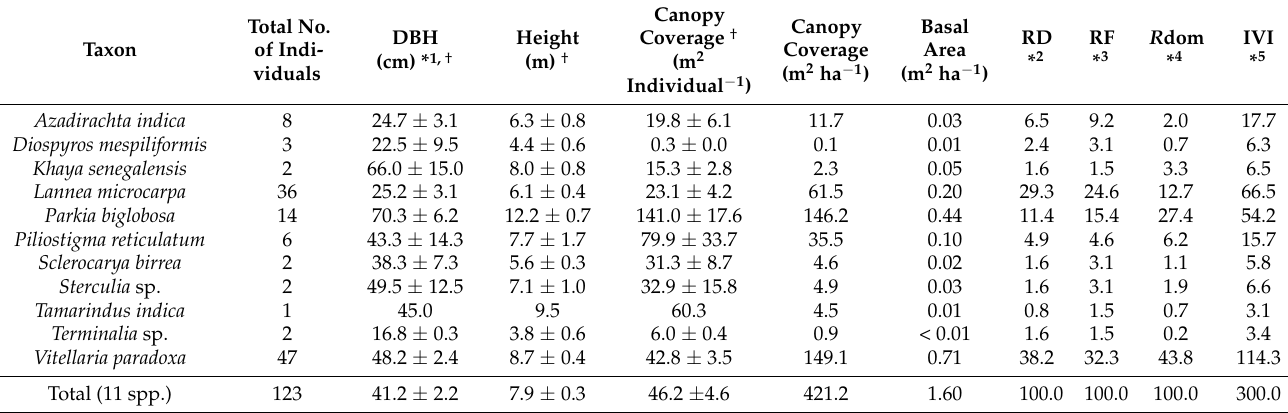
Table 2. Growth parameters and importance value index of existing woody plants with diameter at breast height ≥ 5 cm.